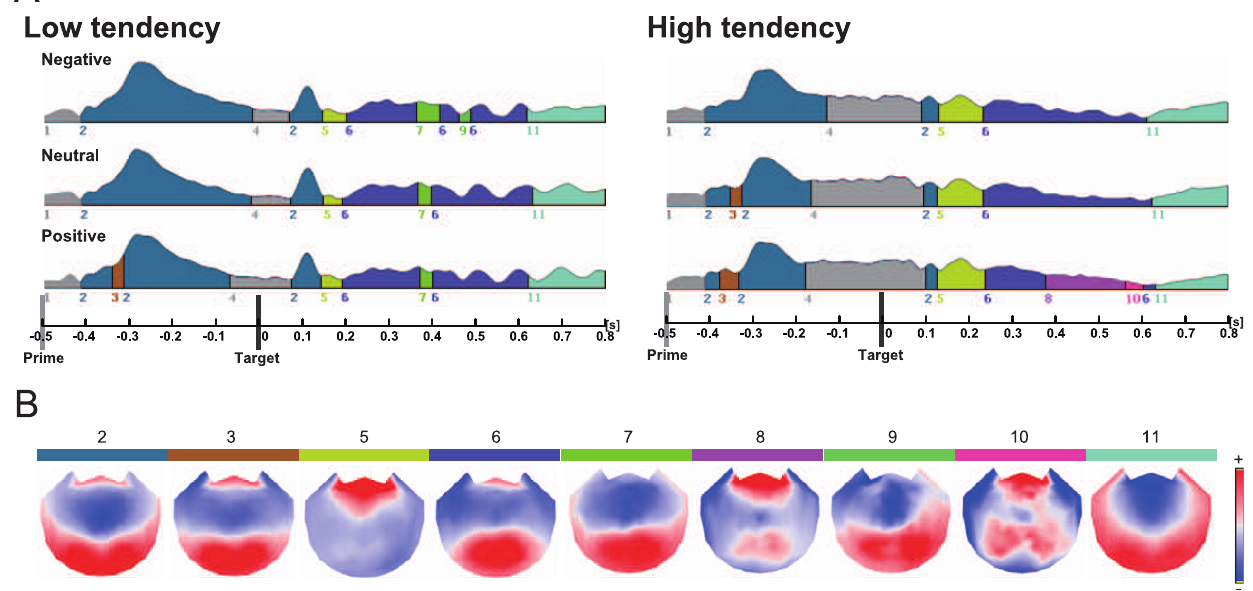
Figure 5. (A) Segments of stable map topography are shown group-wise (left: Low tendency, right: High tendency) for each stimulus condition. (B) Map topographies with the bar of corresponding color; positive voltages in red, negative in blue. These maps are 2-D projections of the 3-D electrode configuration (view from above, nasion on top).